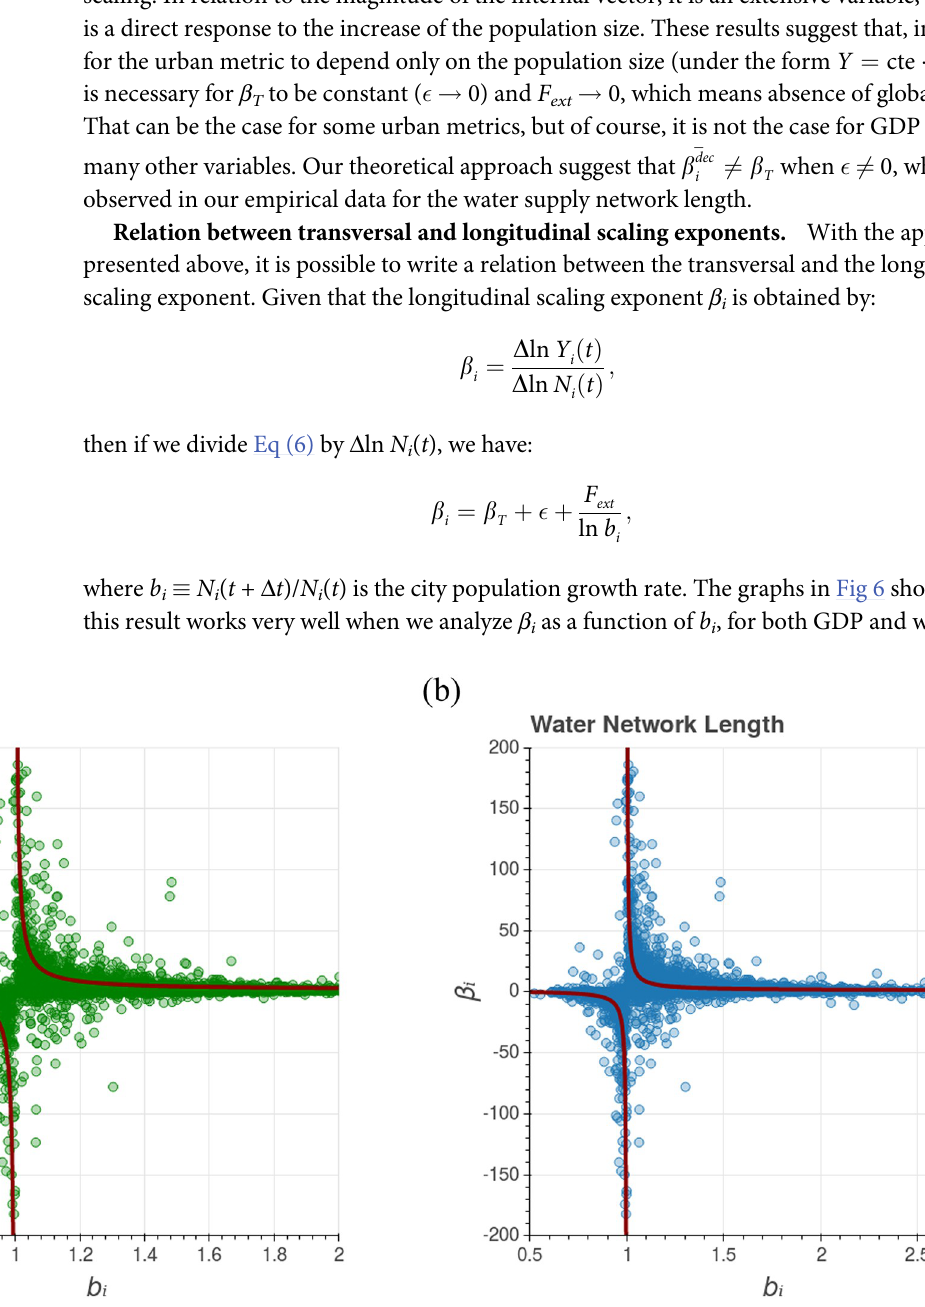
PLOS ONE | https://doi.org/10.1371/journal.pone.0233003 May 19,